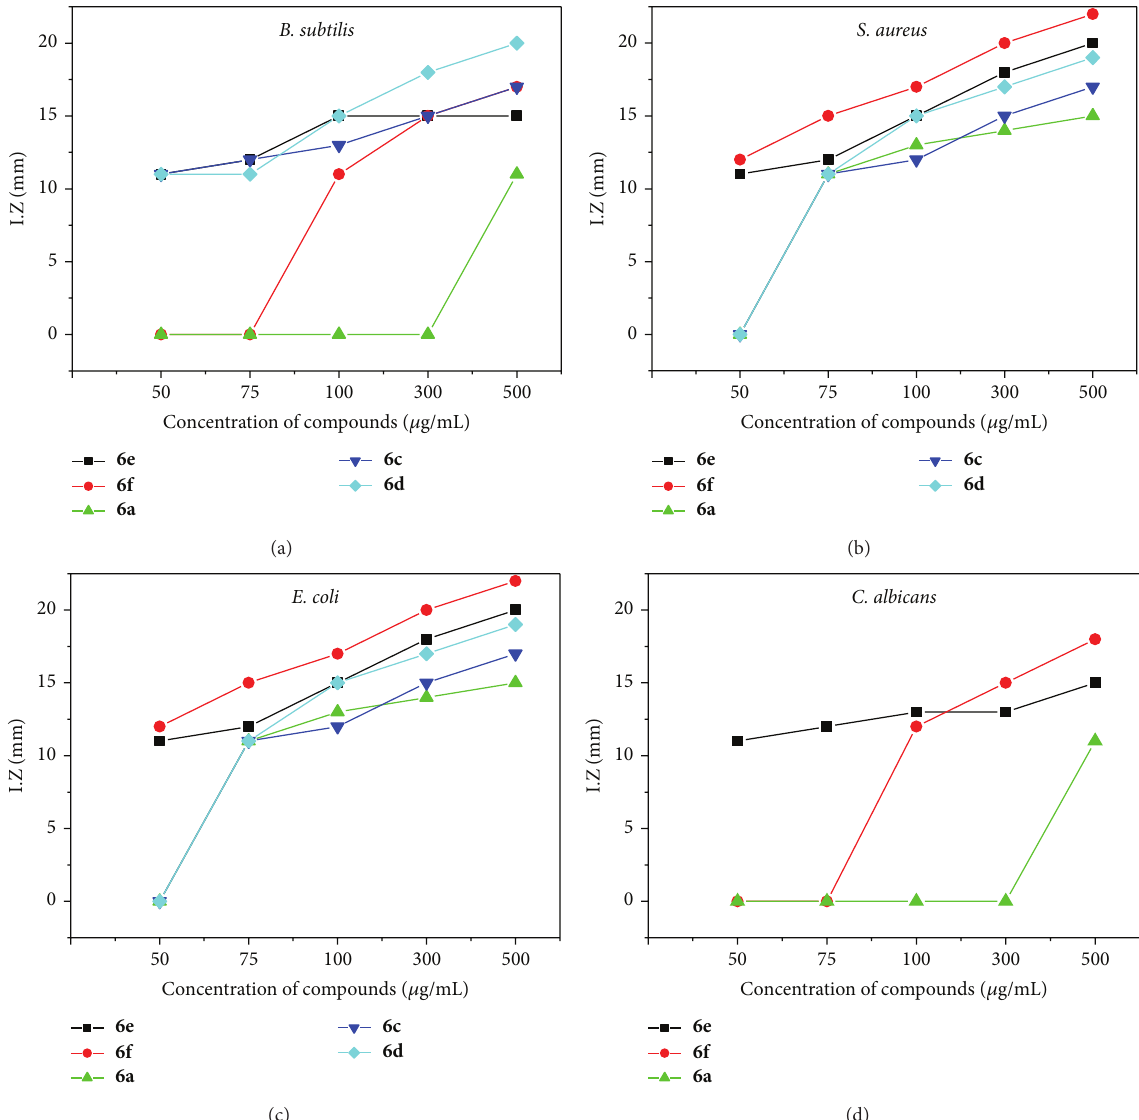
Figure 3: MIC of compounds against Gram-positive bacteria ( B. subtilis ) (a) and ( S. aureus ) (b), Gram-negative bacteria ( E. coli ) (c), and yeast ( C. albicans )